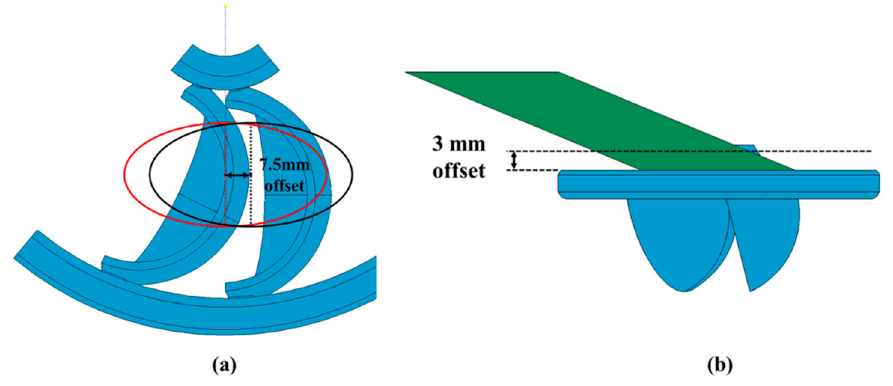
Figure 9. Optimization of the jet aim position shown in ( a ) plan view and ( b ) side elevation. The original jet aim position is shown in red with the optimised position in black.